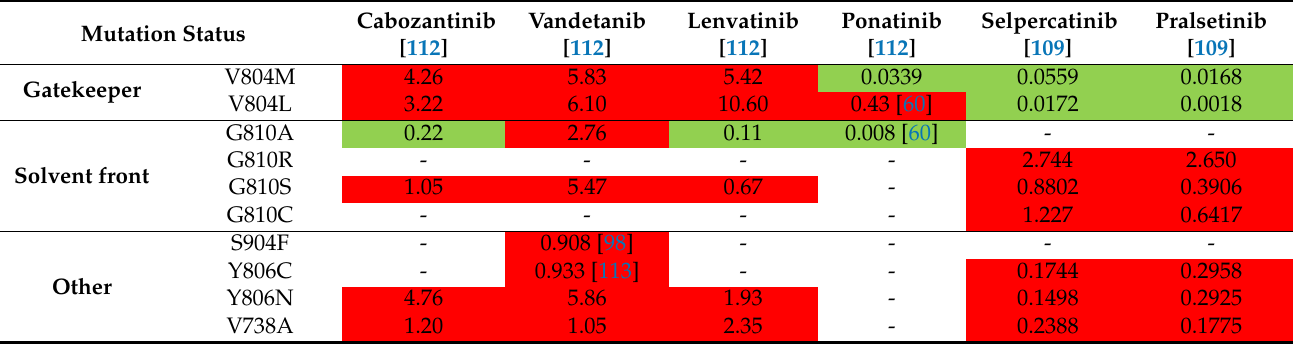
Table 3. Mechanisms of resistance and IC 50 ( µ M) for each